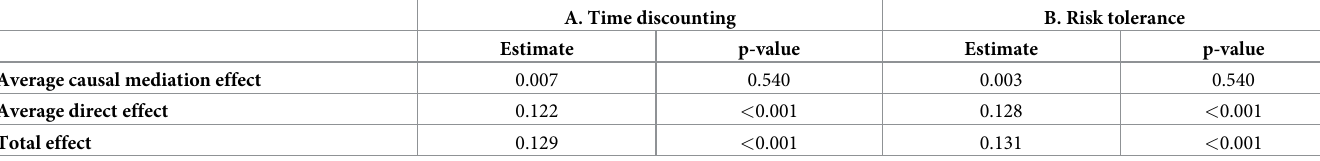
Table 4. Causal mediation analysis of time discounting and risk tolerance in the gender-speeding